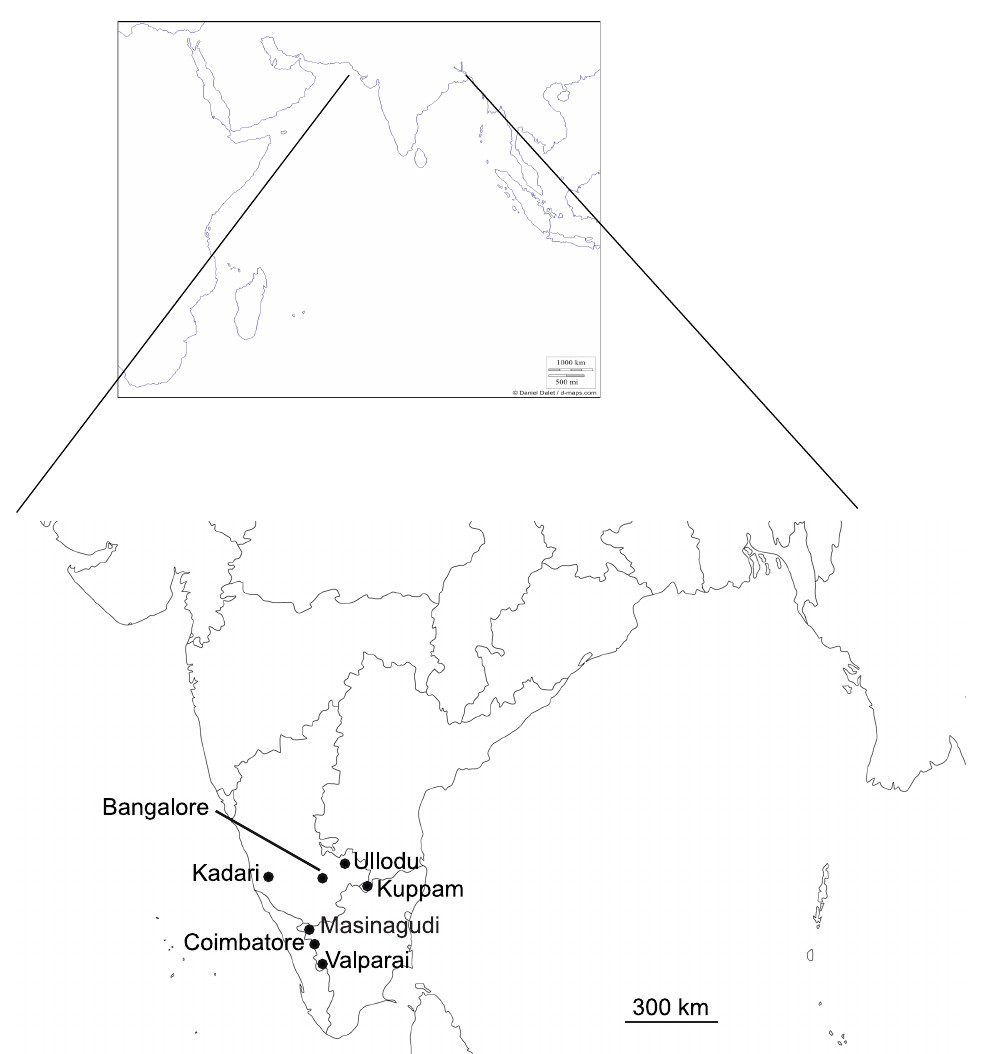
Figure 1. The sampling sites of field crickets in Southern India.